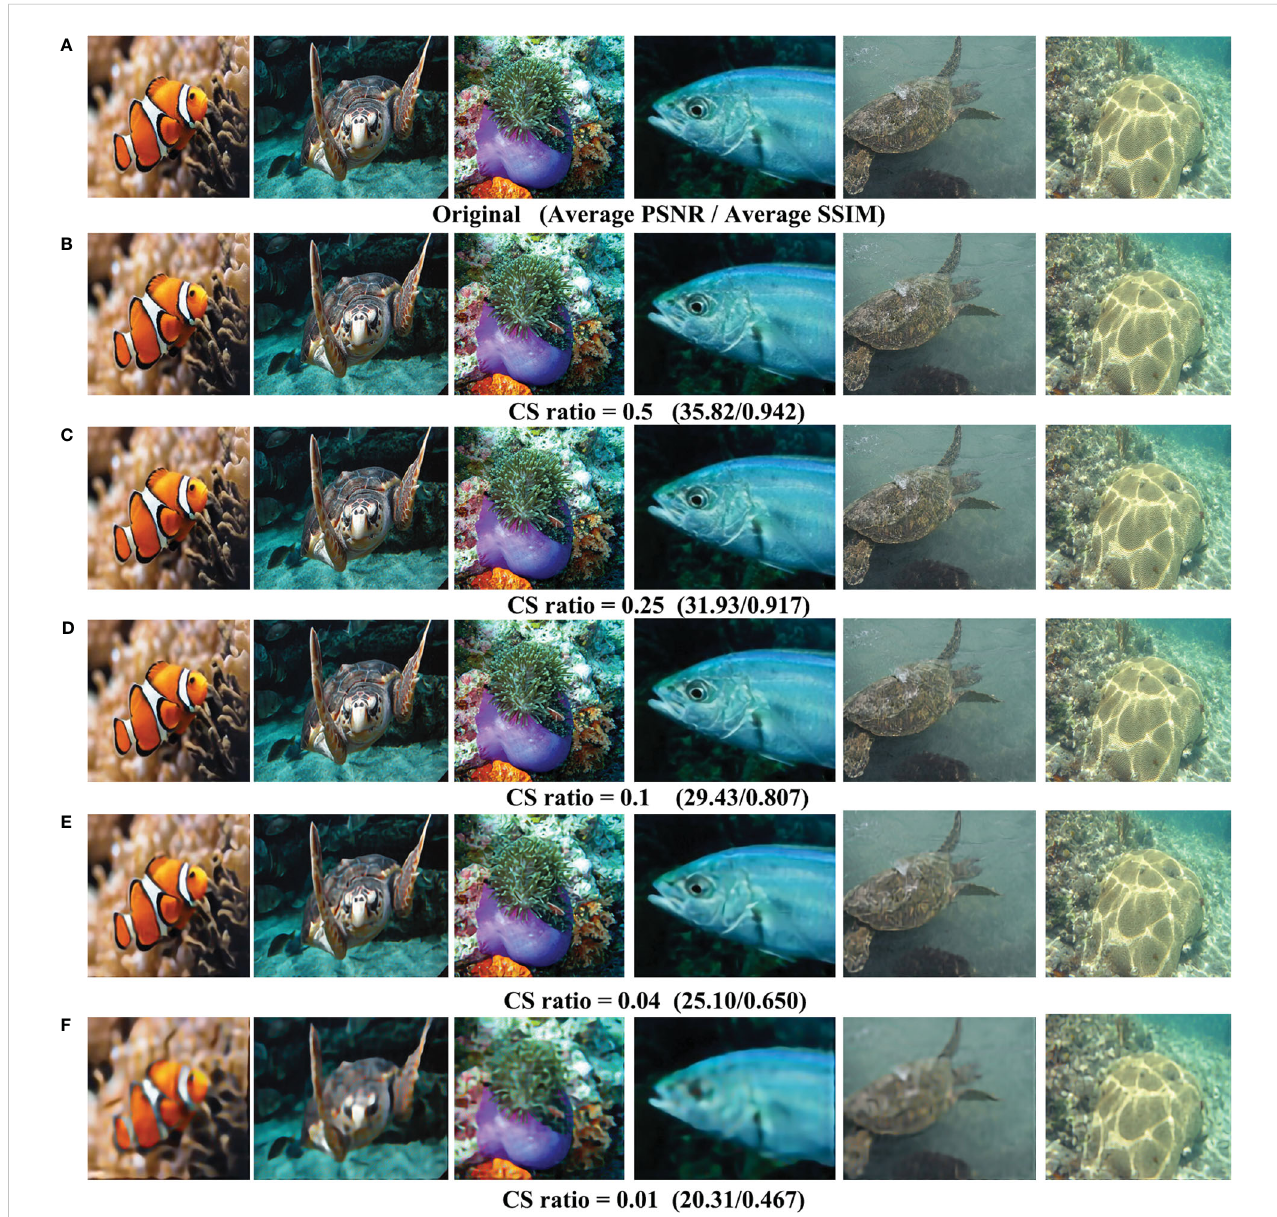
FIGURE 2 Reconstructed underwater images (size of 256×256) by ESPC-BCS-Net at different CS ratios. (A) The original underwater images. (B – F) Reconstructed underwater